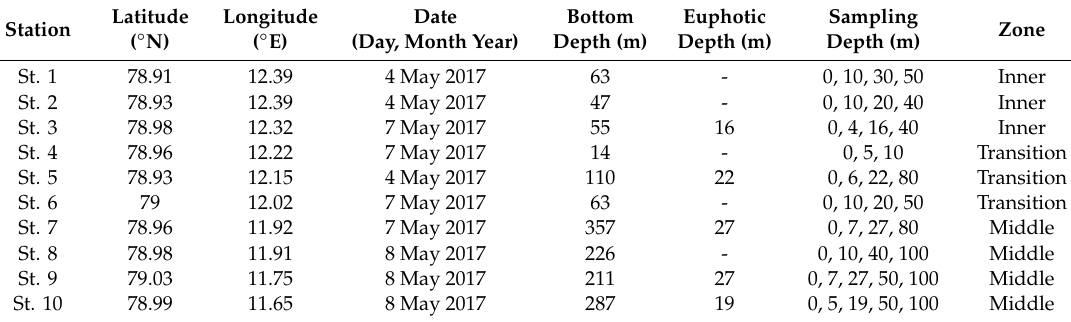
Table 1. Sample location with corresponding sampling depth for nutrient, chl-a, andphytoplankton taxonomy samples in Kongsfjorden in 2017.